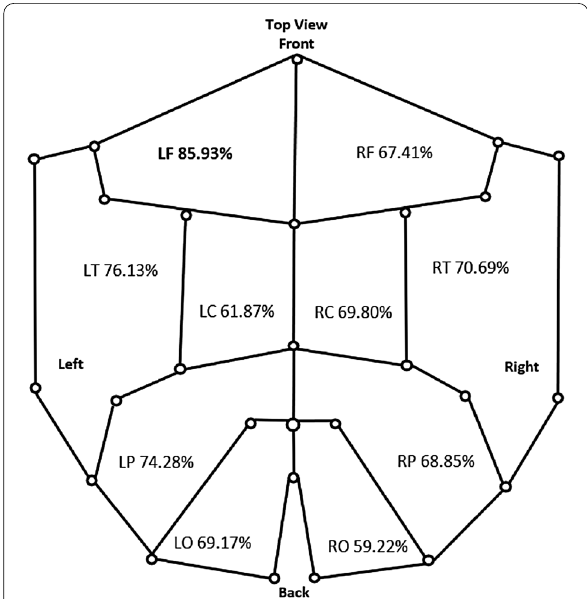
Fig. 3 ROI separation and the respective effectiveness for the three‑class classification, note the six sensors in the centerline are excluded for this symmetric analysis. Each label indicates the mean accuracy for the three‑class classification, using the hybrid LOO– MCRS cross‑validation approach for evaluation. Note these results are obtained through the magnetometer–gradiometer score‑level